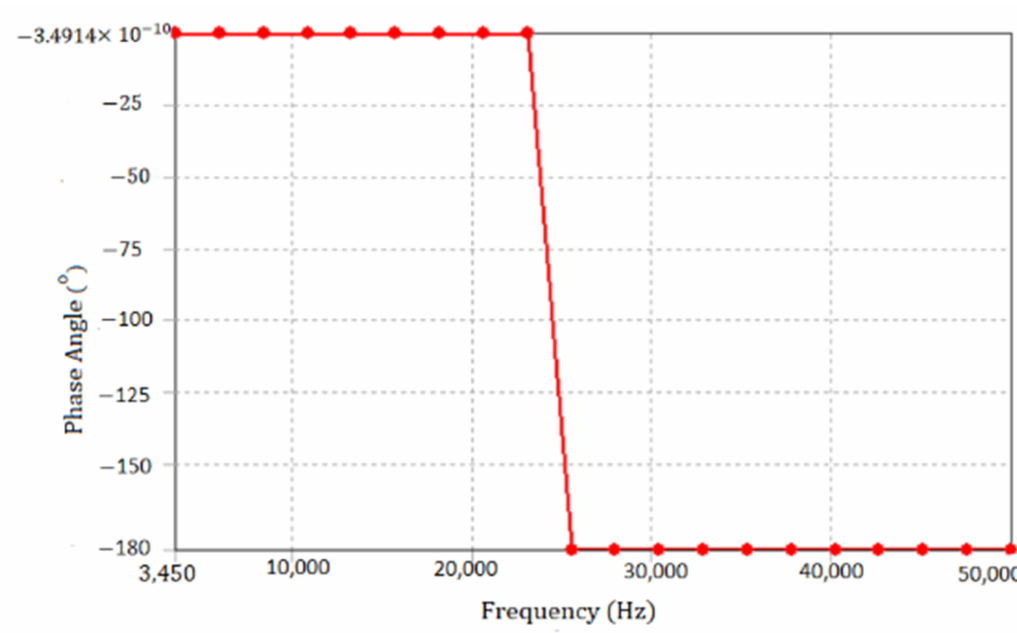
Figure 17. Frequency vs. phase angle graph of the